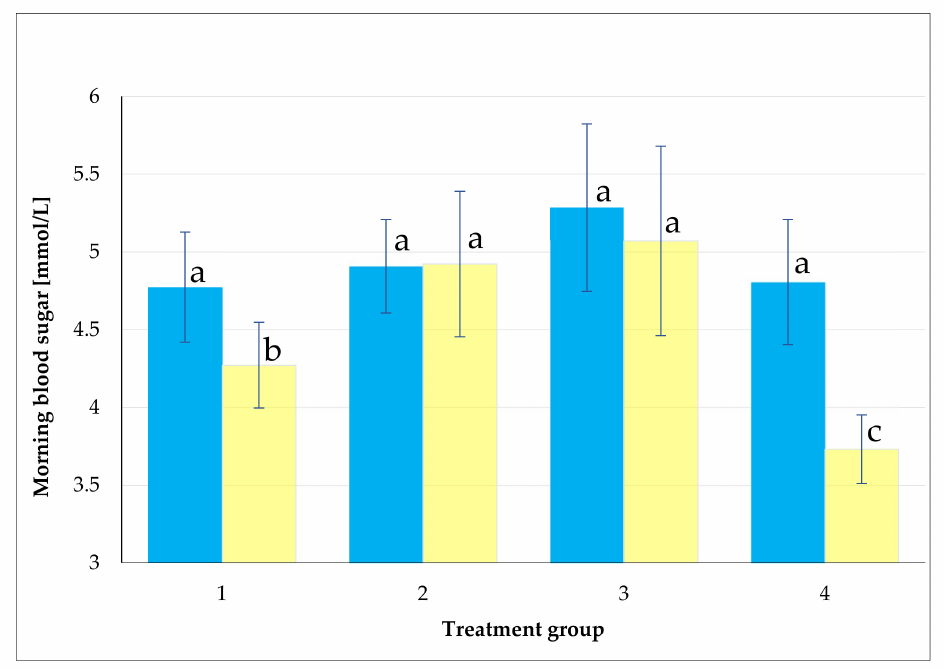
Figure 2. Mean values of morning blood sugar of the participants before (blue column) and after (yellow column) the human clinical trial. The treatment groups included group (1) acacia honey + yogurt; group (2) green algae honey + yogurt; group (3) sea buckthorn honey + yogurt; and group (4) walnut honey + yogurt. The participants received 30 g of honey product in 150 g of yogurt for 21 days. The blood samples were taken before and after the 21-day trial. The same letters mean the values were not significant at 5%.